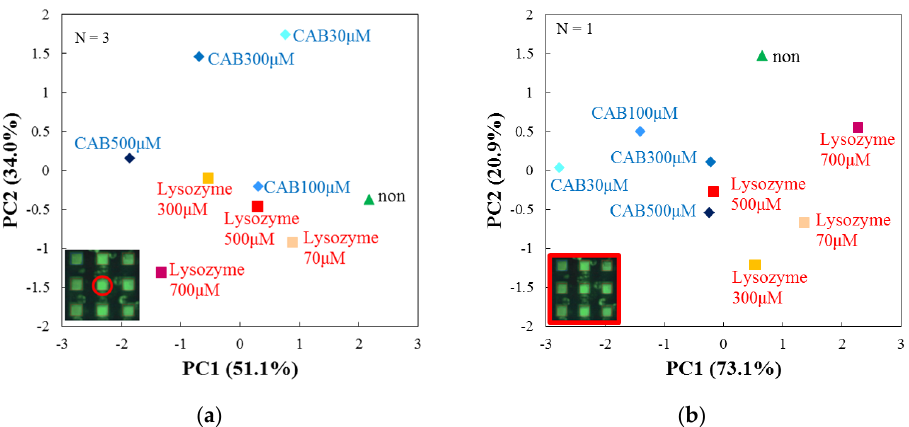
Figure 7. ( a ) PCA score plot (N = 3) of averaged RF’s for multi-shots of single microwell; ( b ) PCA score plot (N = 1) of RF’s for single-shot of arrayed microwells. The RF’s are for DPPC, DSPC and DPPC/Cholesterol after 60 min from the initial addition of target proteins.